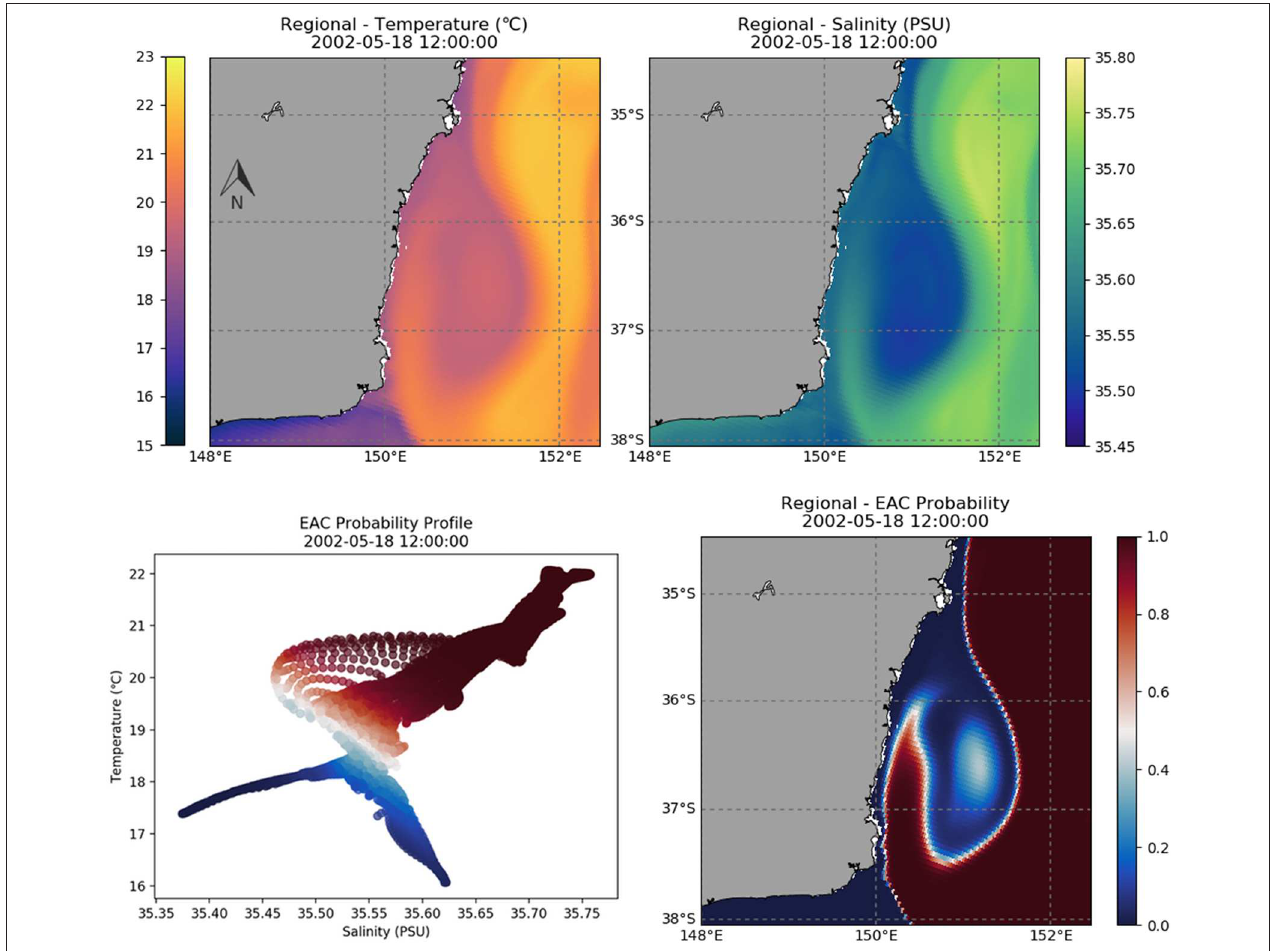
FIGURE 4 | Example output of the East Australian Current (EAC) classification algorithm for the 18th of May, 2002. The top panels show temperature (left) and salinity (right) inputs from the ROMS dataset. The bottom right panel shows the EAC probability for the region calculated using the logistic regression algorithm, with a probability < 0.5 being classed as non-EAC and > = 0.5 classed as EAC. The bottom left panel shows the temperature salinity profile of model-predicted EAC water at the given time-step. An animation of these plots for the full 22 year model run can be viewed here: